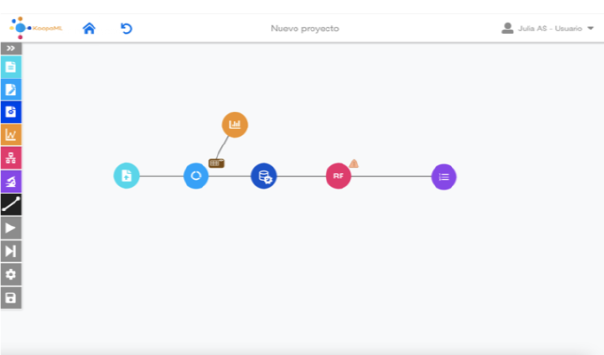
Figure 2. Digital prototype of the personal area for expert users.